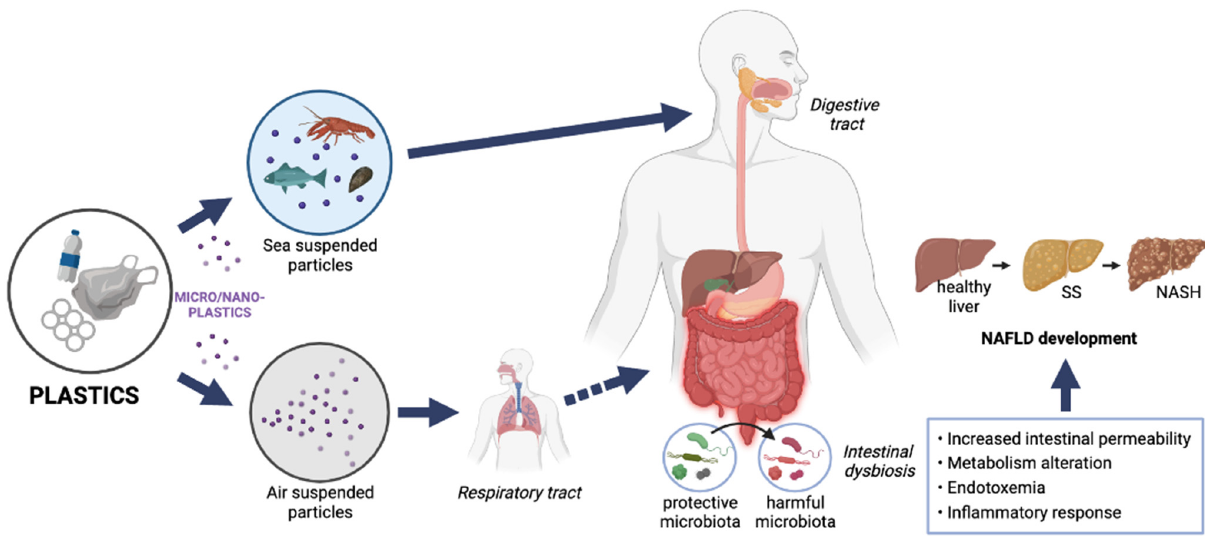
Figure 1. Microplastics and nanoplastics from plastic degradation enter organisms mainly through the digestive and respiratory systems (from this last system, microplastics pass to the digestive system by swallowing), producing changes in the gut microbiota that could induce intestinal dysbiosis. Intestinal dysbiosis triggers injuries (alterations of metabolic homeostasis, disruption of the intestinal barrier, endotoxaemia, and inflammatory response) that can cause health disorders, such as NAFLD [22,23]. NAFLD, nonalcoholic fatty liver disease; SS, simple steatosis; NASH, nonalcoholic steatohepatitis.